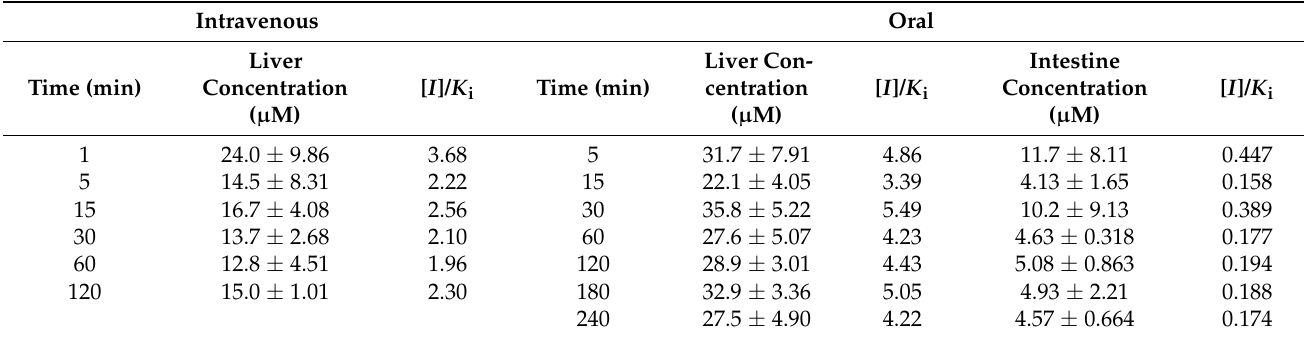
Table 4. Mean ± standard deviation (SD) concentration ( µ M) of voriconazole in the liver and intestine after the intravenous and oral administration of voriconazole and tofacitinib to rats.